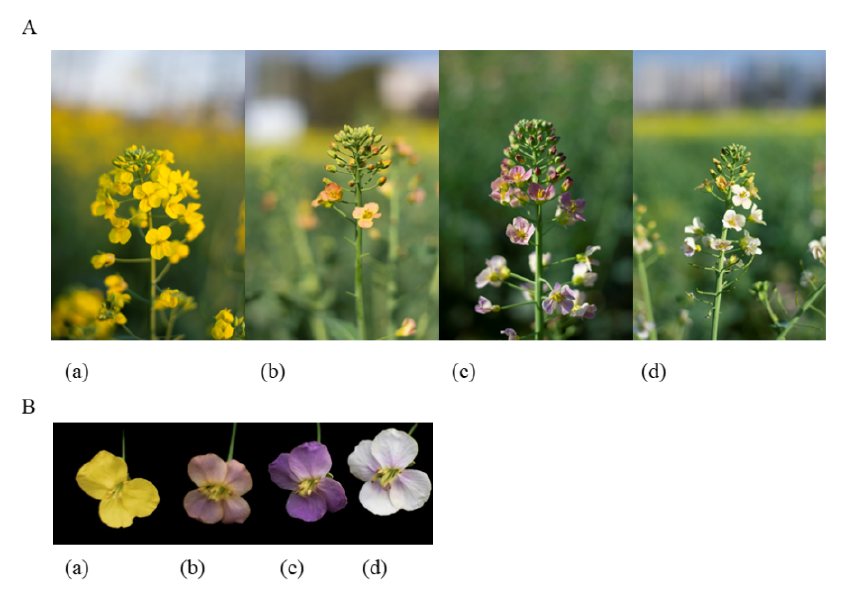
Figure 1. The phenotypes of the four differently-colored flowers of Brassica napus ( A ) The wild phenotype ( B ) Rapeseed petals. ( a ) Yellow petals, ( b ) yellow/purple petals, ( c ) purple petals, ( d ) light purple